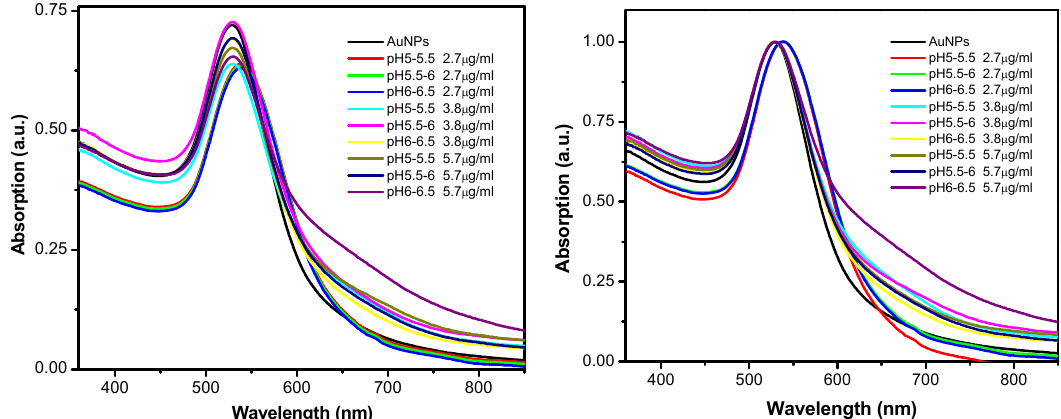
Fig. 3. UV-VIS spectra of colloidal gold and the IgG antibody with titration procedure at different pH of colloidal gold and diverse concentrations of antibody after addition of NaCl (top) and Normalized UV-VIS spectra of colloidal gold and IgG antibody with titration procedure at different pH of colloidal gold and diverse concentrations of antibody after addition of NaCl (bottom).